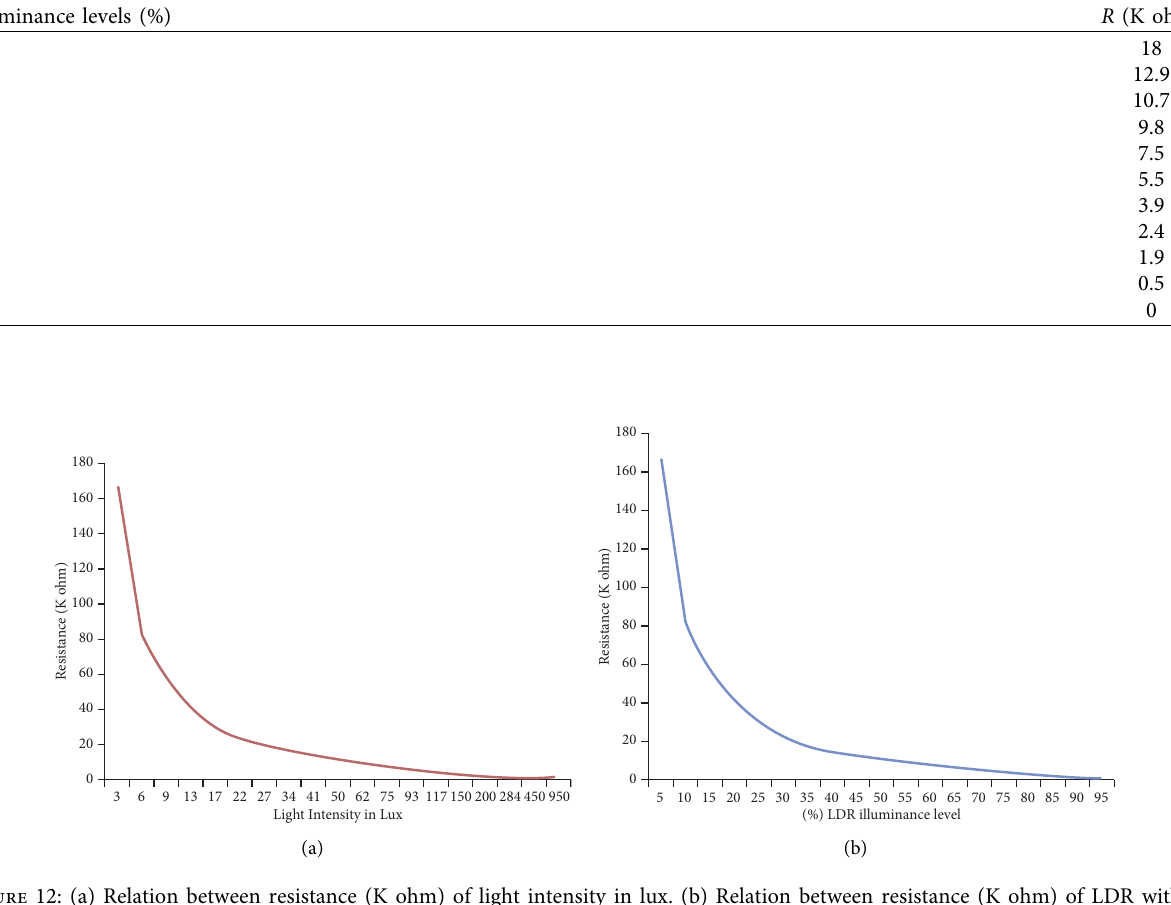
Table 4: Relation between resistance values of LDR with % illuminance level.